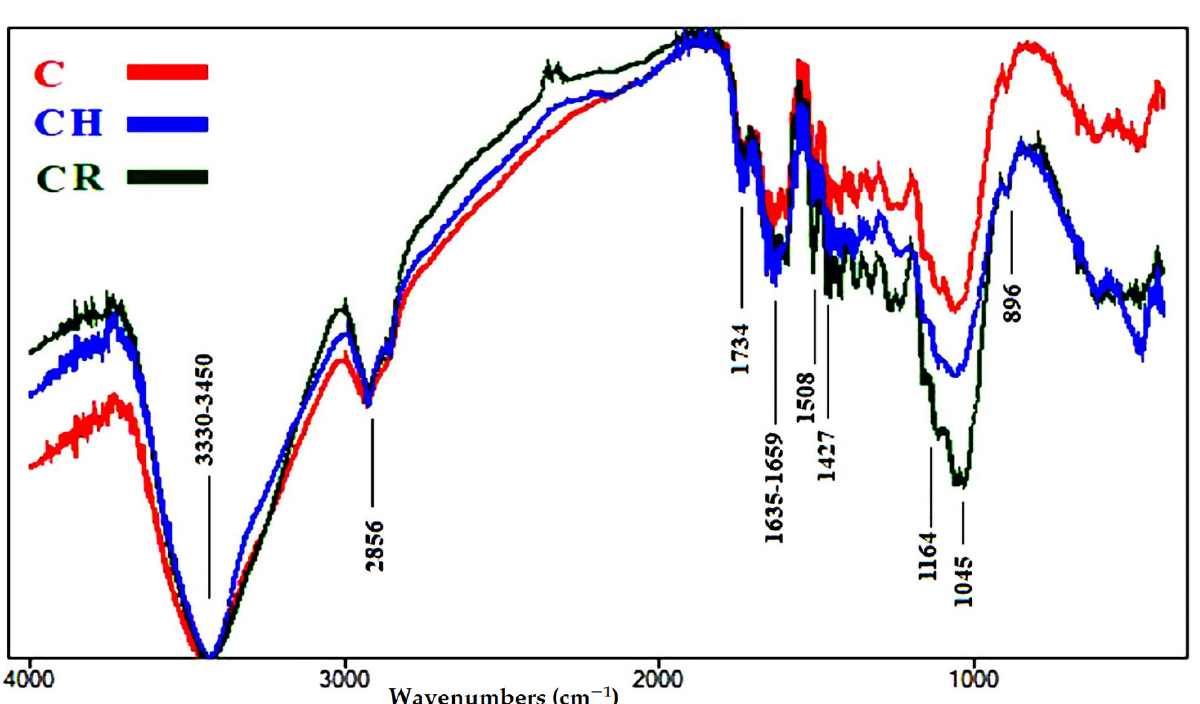
Figure 6. FTIR spectra of the wood sample of Tectona grandis (C, control; CH, heat ageing; CR, rusted ageing).